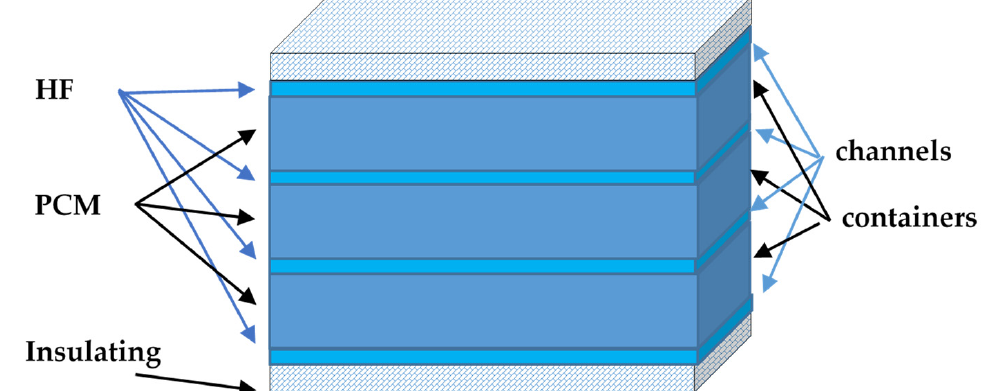
Figure 1. Schematic of the rectangular latent heat storage tank.